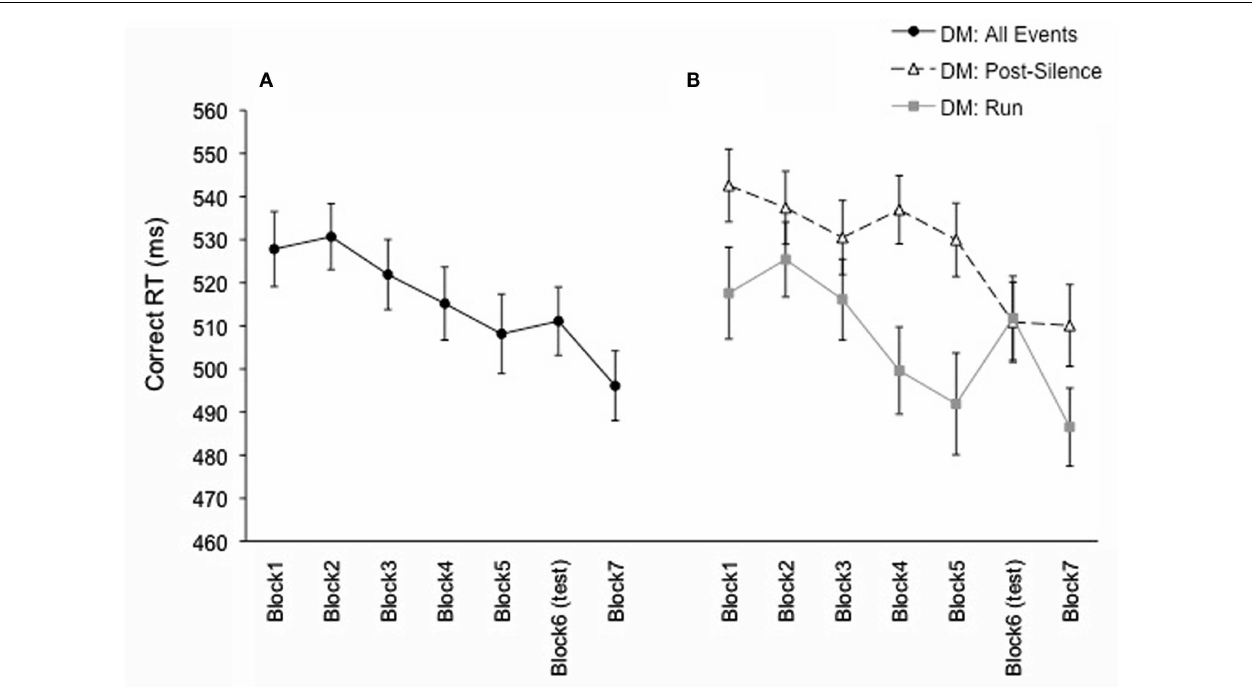
FIGURE 4 | Mean correct RT for Experiment 2 (exposure and test block were Duple Meter), presented as a function of block in (A) and as a function of block separated by event-type (run vs. post-silence) in (B). Error bars represent the standard error of the mean.